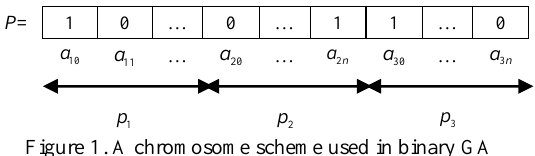
Figure 1. A chromosome scheme used in binary GA